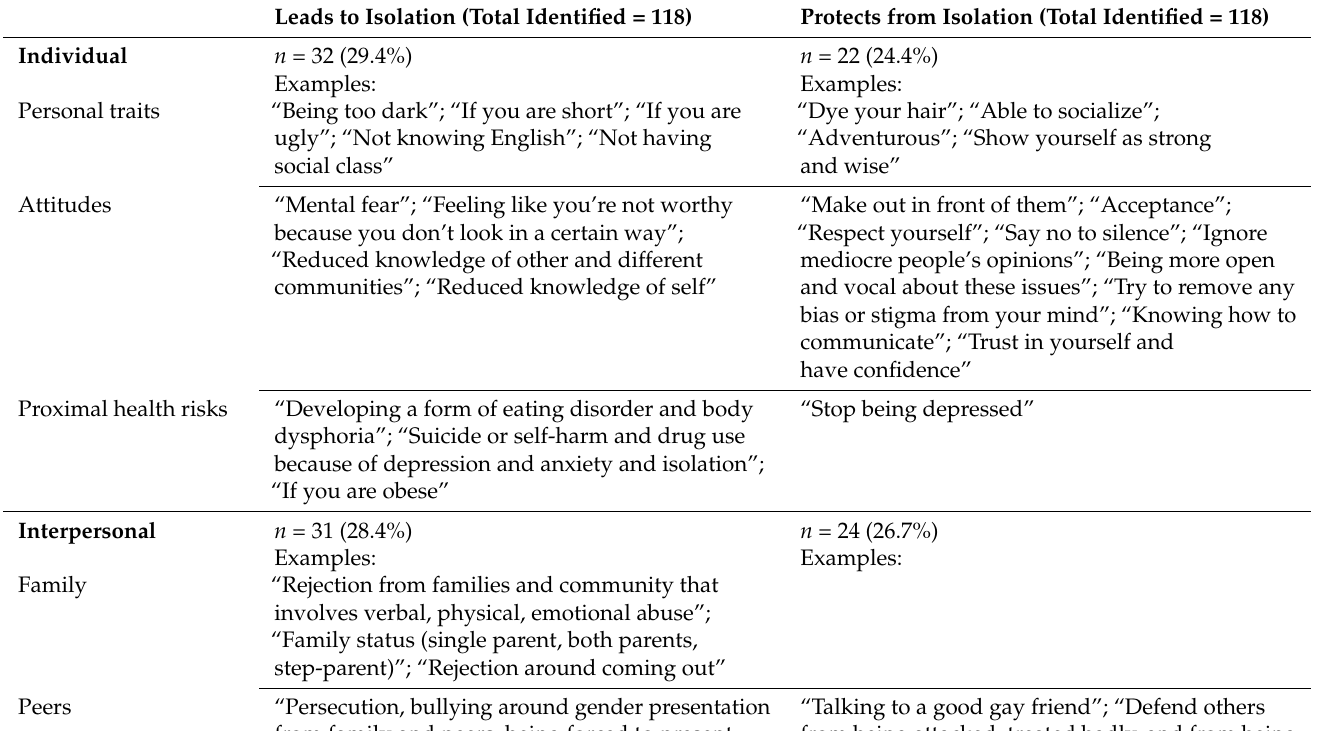
Table 2. Latinx LGBTQ+ Youth’s Perspectives on Social